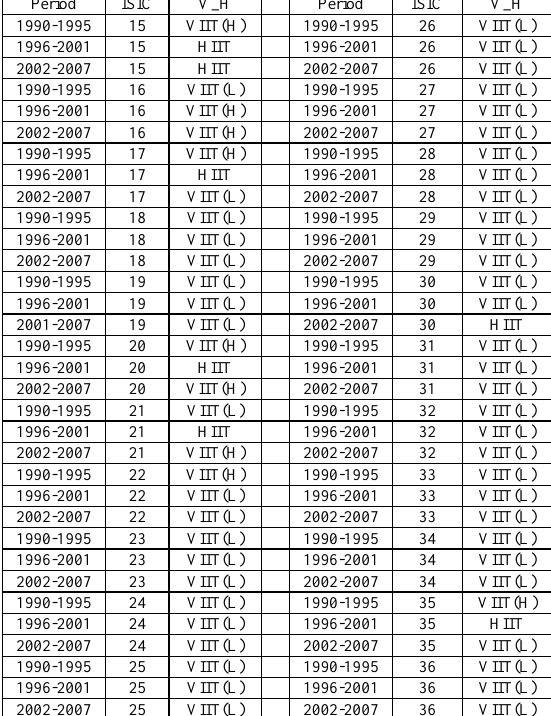
Table 8: Number of Sectors before and after Customs Union